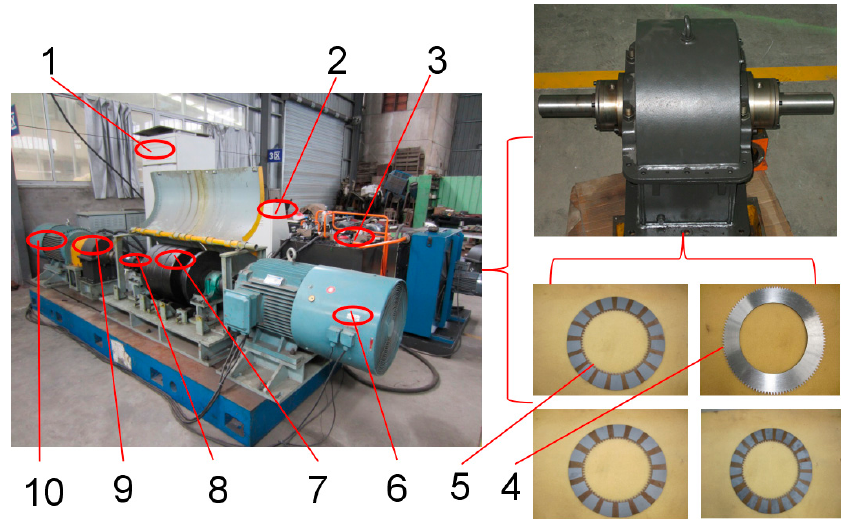
Figure 10. Schematic diagram of the HVC test rig.